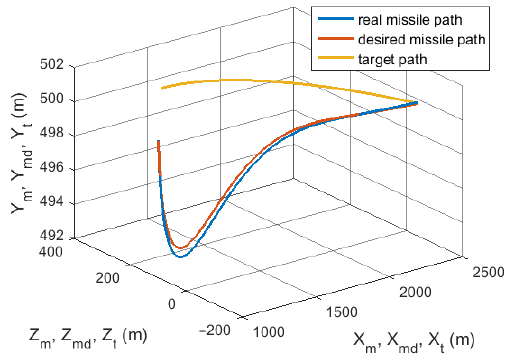
Figure 4. Missile and target flight